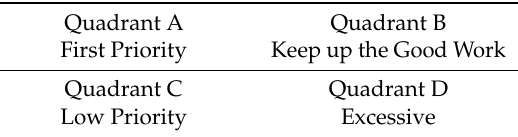
Table 3. Cartesian Diagram of